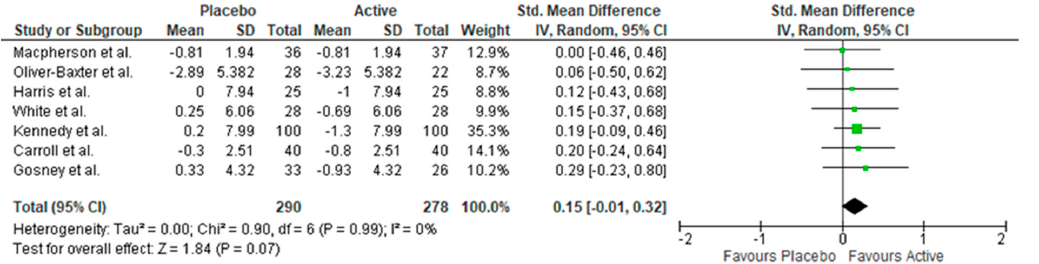
Figure 2. Forest plot of meta-analysis of depressive symptoms.